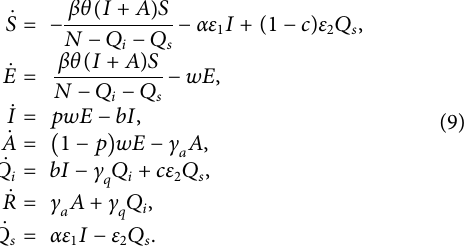
FIGURE 7 Trends in various proportions of symptomatic infections in groups S ( t ), I ( t ) and A ( t ). The solid blue line represents p = 0.14252, which istheestimatedvaluein datatypeB-7.The red indicates p = 0.3, the yellow is p = 0.5 and the purple denotes p = 0.7.